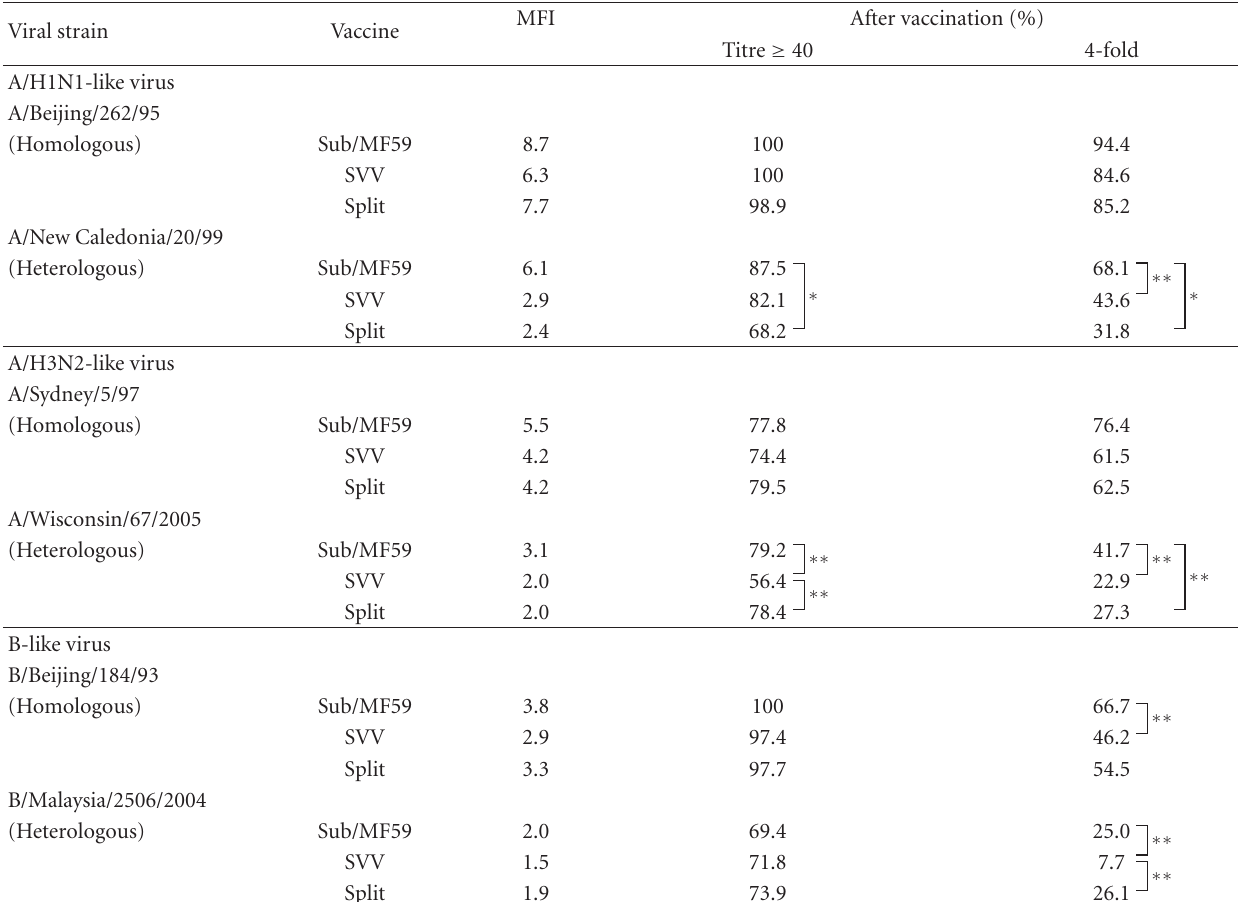
Table 2: Mean Fold Increase in titres (MFI), Seroprotection ( ≥ 40), and 4-fold increase rates according to viral strain and vaccine group. Viral strain